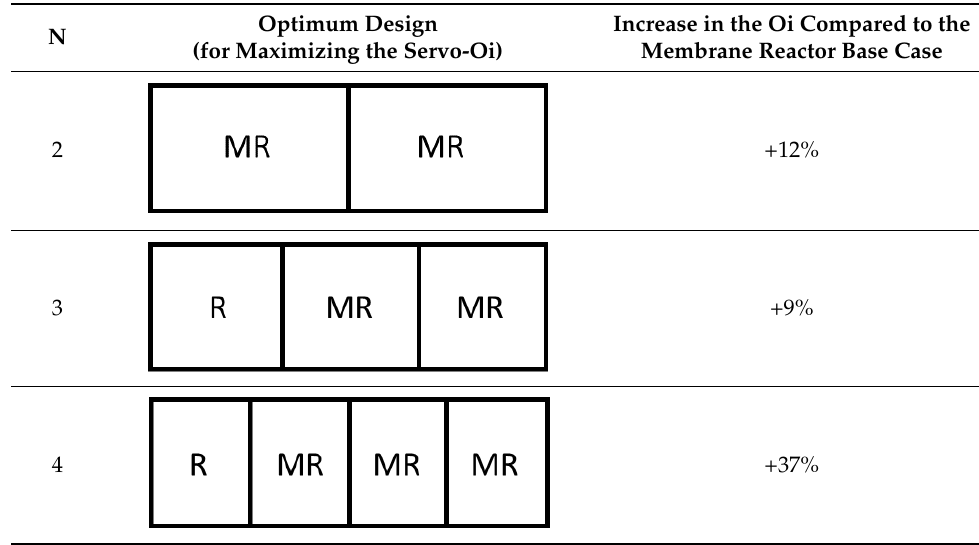
Figure 14. The AOS of the original membrane reactor is shown (in blue/green). The area of the overlap (green) with the DOS (white) has an OI of 0.129 meaning the membrane reactor can achieve 12.9% of the DOS. Table 5. Summary of the operability and optimization analyses for maximizing the servo-OI.